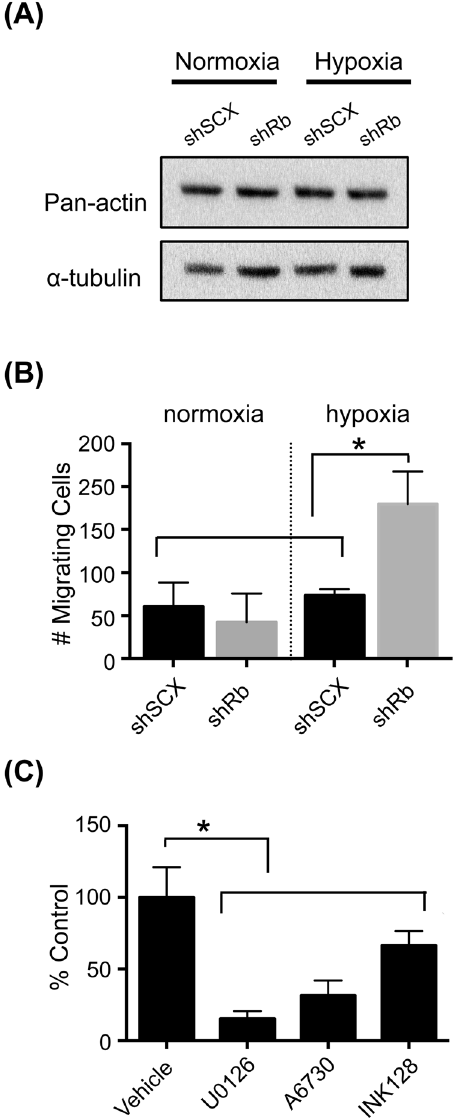
Figure 7. Exposure to hypoxia increased the total number of migrating shRb LNCaP cells. ( A ) Immunoblot of LNCaP shRb and shSCX whole cell lysates after exposure to 72 h of hypoxia or normoxia and probing with primary antibodies to pan-actin or α -tubulin. Samples were derived from the same experiment and blots were processed in parallel. Complete blot images are shown in Supplementary Information File 1, Figure S1. ( B ) Total number of migrating cells for shRb and shSCX LNCaP cells after exposure to hypoxia or normoxia. ( C ) Total number of migrating cells for shRb LNCaP cells conditioned with hypoxia and treated with DMSO, 10 μ M U0126, 2 μ M A6730 or 10 nM INK128. Experiments were performed in triplicate. Error bars represent ± S.D. * p <